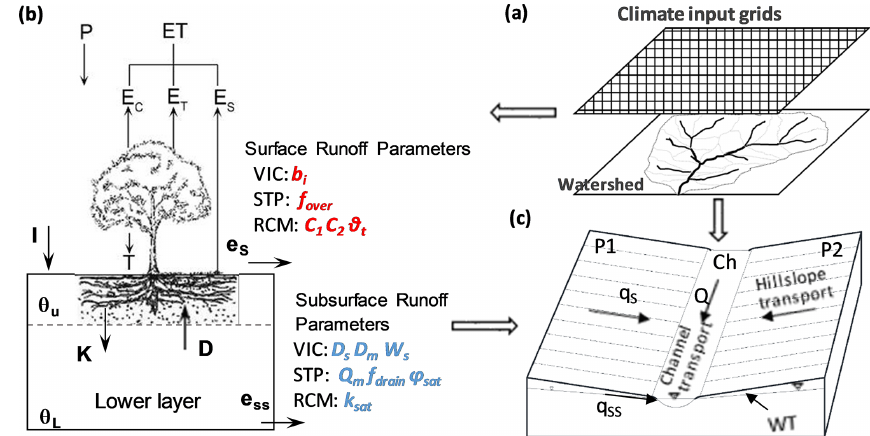
Figure 2. The conceptual framework of the hydrologic models used in this study. Portions of this figure were adapted from the work of Beighley et al. (2009). (a) shows the grid-based climate inputs for hydrologic models; (b) shows water balance models; P is precipitation; ET is evapotranspiration; E s is soil evaporation; E c is canopy evaporation; E T is transpiration; e s is water available for surface runoff; e ss is water available for subsurface runoff; θ U is relative soil moisture in the upper soil layer; θ L is relative soil moisture in lower soil layer; I is infiltration; K is water flux from the upper layer to the lower layer; and D is diffusive water flux from the lower layer to the upper layer; (c) shows the HRR routing model; the “open-book” assumption: two identical planes (P1 and P2) with the channel (Ch) in the center of each sub-basin; q s is surface runoff; q ss is subsurface runoff; Q is discharge in the river channel, and WT is the groundwater table. The parameters in red italic are for surface runoff generation; the parameters in blue italic are for subsurface runoff generation. The first columns in the tables indicate the models that the parameters are used for. The definition of these parameters can be found in the